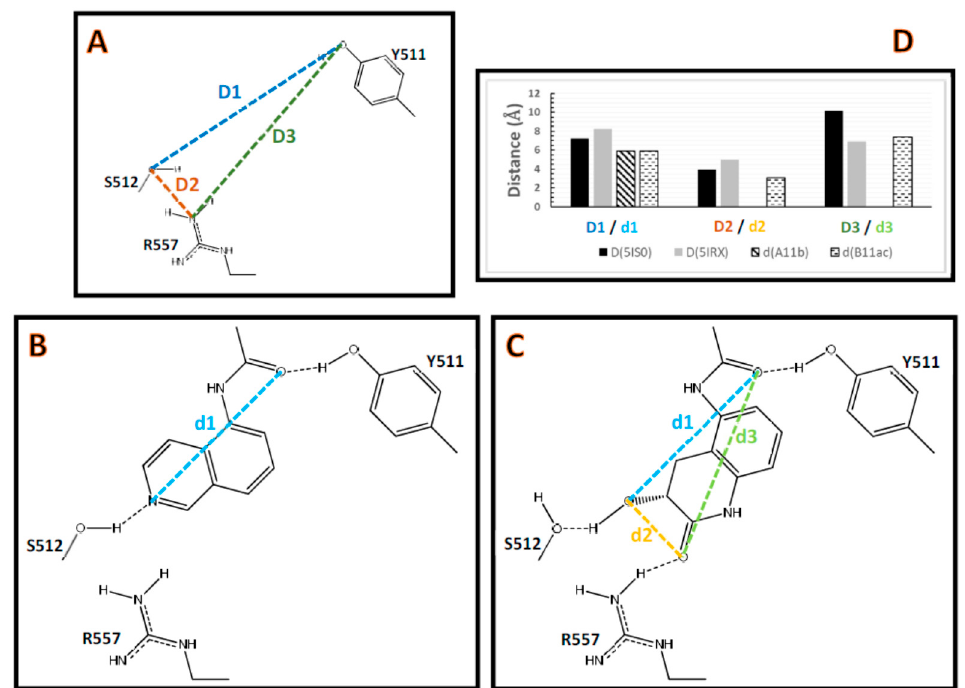
Figure 5. Distances D between the residue atoms involved in the HBs and the distances d between the ligand atoms involved in the HBs. ( A ) Definitions of the distances D1 , D2 , and D3 in the TRPV1 structure. ( B ) Definition of the distance d1 in the compounds from series A. ( C ) Definitions of the distances d1 , d2 , and d3 in the compounds from series B. ( D ) Values of distances D in the structure prepared from the Protein Data Bank (PDB) with code 5IS0 for docking calculations (the original PDB formed a complex with the antagonist capsazepine) and in the structure from the PDB with code 5IRX (which formed a complex with the agonist resiniferatoxin); values of the distances d in the docked poses of compounds A11b and B11ac representing compounds from series A and B are also